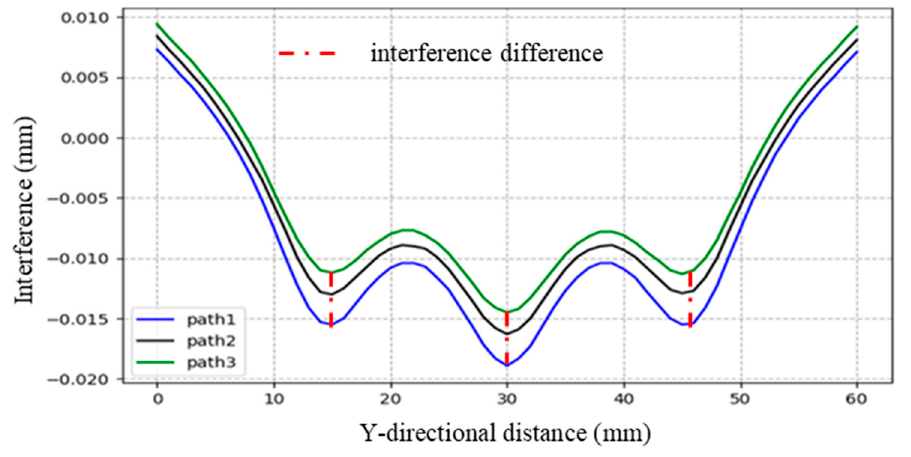
Figure 10. The rivet interference of the Y-direction path.